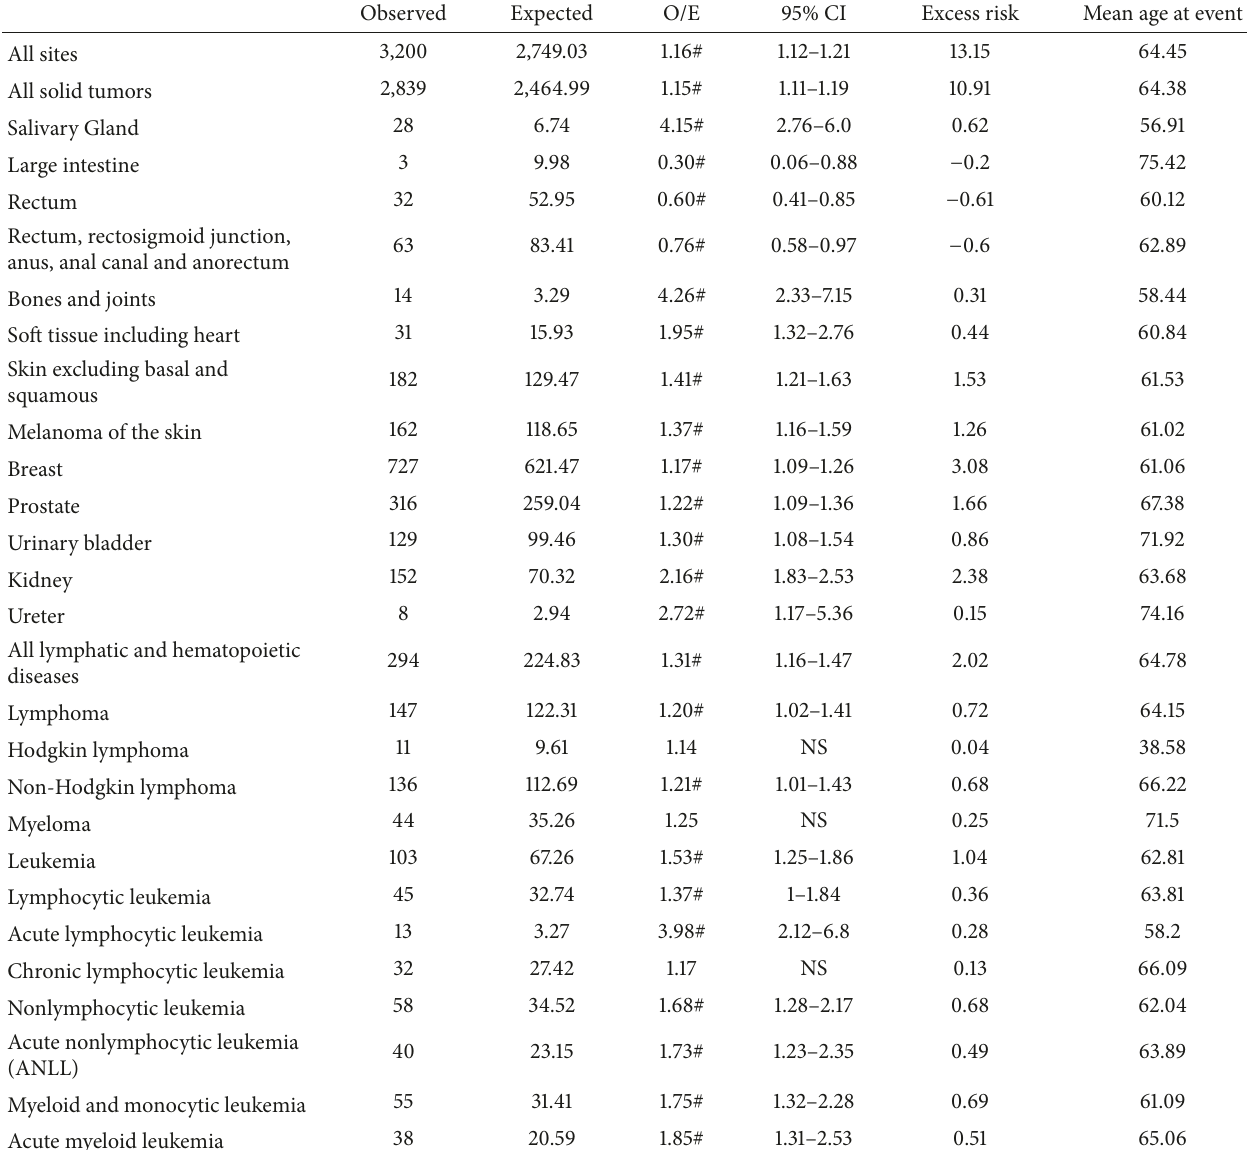
(Table 2) compared to nonradiation group (O/E 1.09;